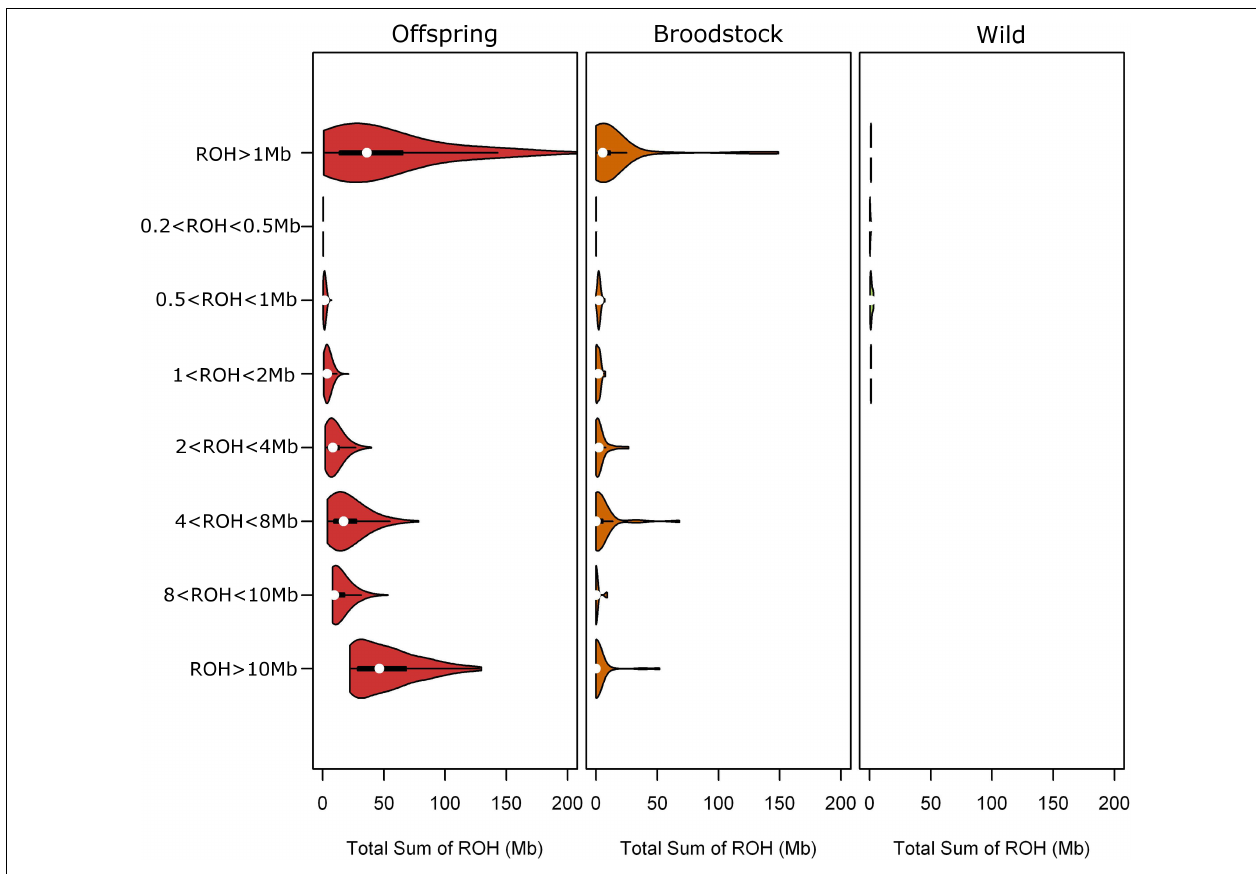
FIGURE 2 | Runs of homozygosity sum distribution for each ROH size category in the domestic and wild populations. ROH < 1 Mb were not considered for F ROH